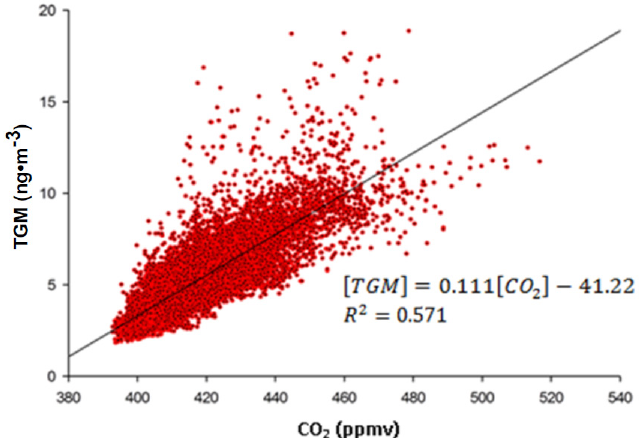
Figure 1. Five-minute average TGM concentrations vs. five-minute average CO ratios during January and February